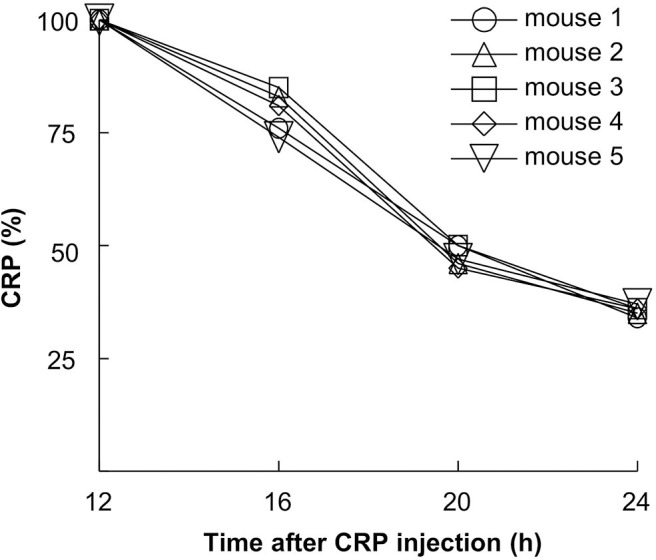
Clearance of H38R CRP from mouse circulation. Mice were injected with 50 μg of CRP. Blood was collected at various time points, sera separated, and the concentration of CRP measured.